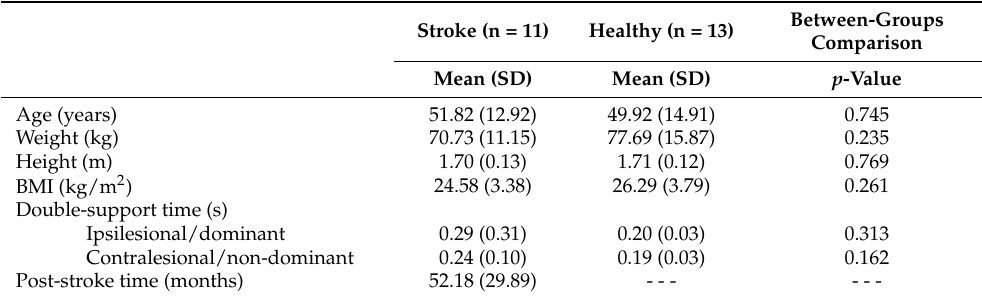
Table 1. Participant characteristics (sociodemographic and clinical). Data presented from the mean (standard deviation (SD)). The p -value reflects the comparison between the stroke and healthy